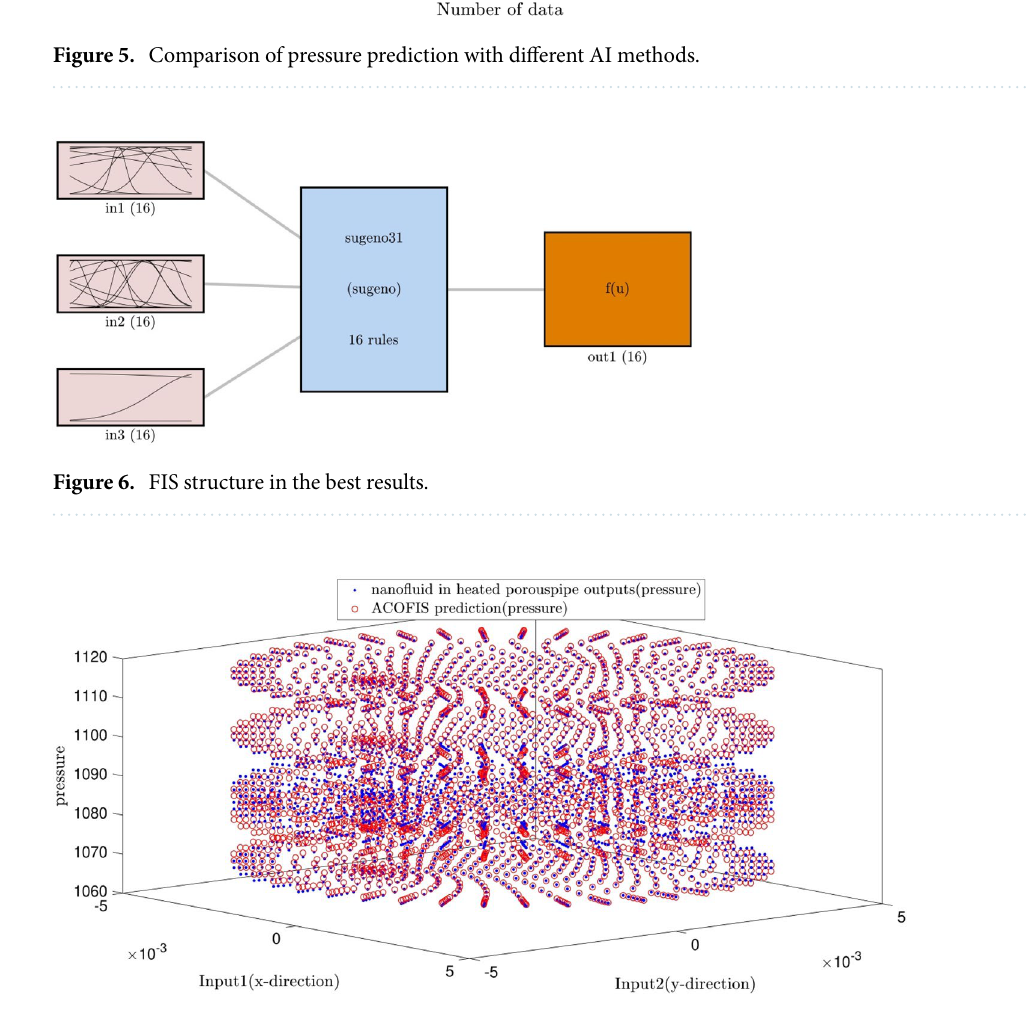
Figure 7. ACOFIS validation with comparison prediction data and CFD